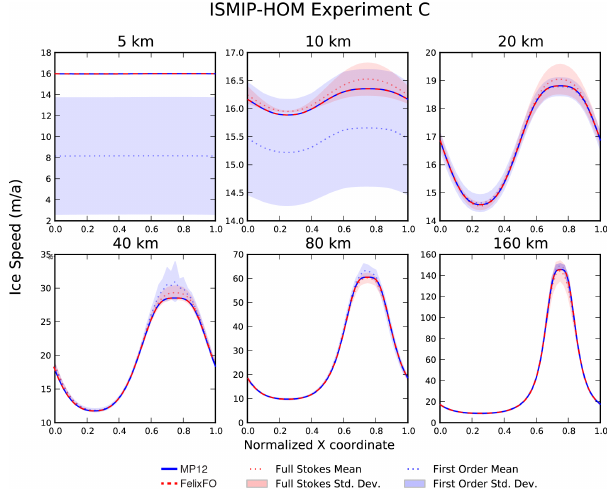
Figure 7. ISMIP-HOM test C: surface velocity component u as a function of x at y = L/ 4 for each L considered. The blue solid line (MP12) represents results from Perego et al. (2012) and the red dashed line (labeled FelixFO) represents results from the current solver. Note that, for the 5km test, the MP12 and FelixFO results directly overly the results for the full Stokes models participating in the original